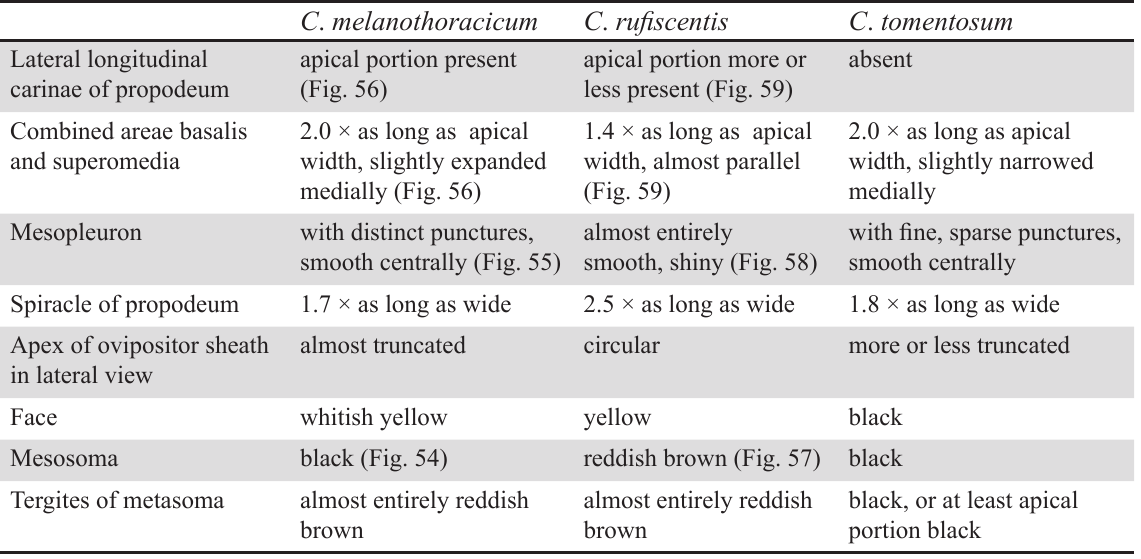
Table 1. Comparision of Chinese species of genus Ctenopelma subgroup tomentosum .